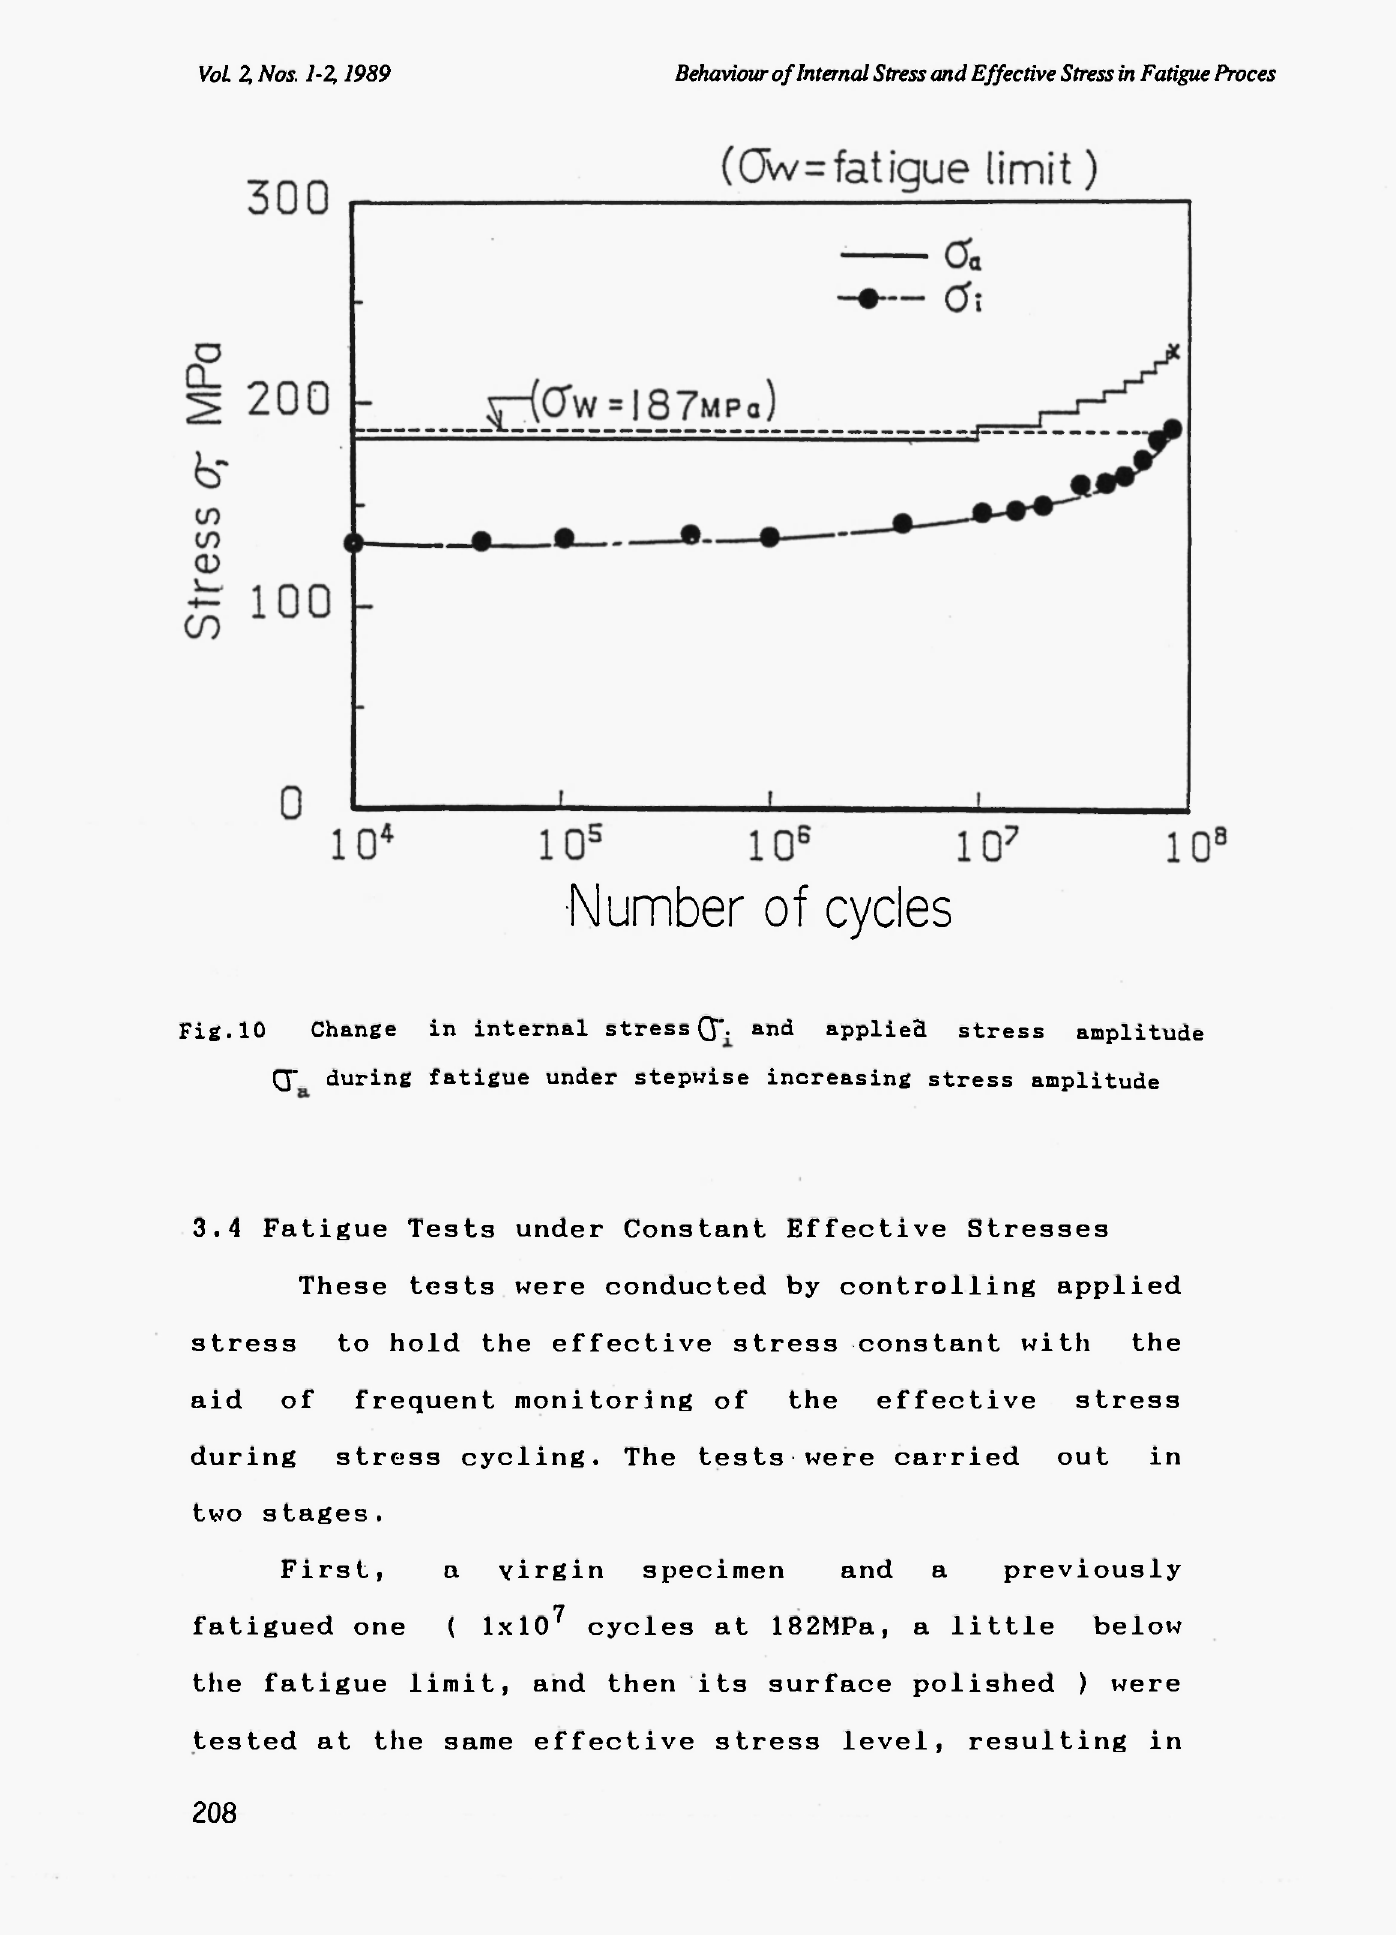
Fig.10 Change in internal stressQ\ and applied stress amplitude